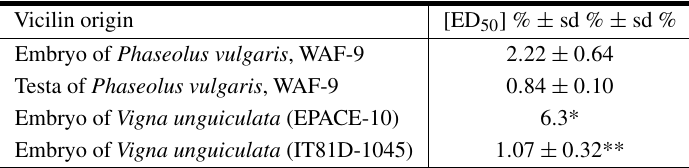
Effective doses for 50% response (ED 50 ± sd) for 20-day larvae of Callosobruchus maculatus fed on artificial seeds containing vicilins isolated from legume